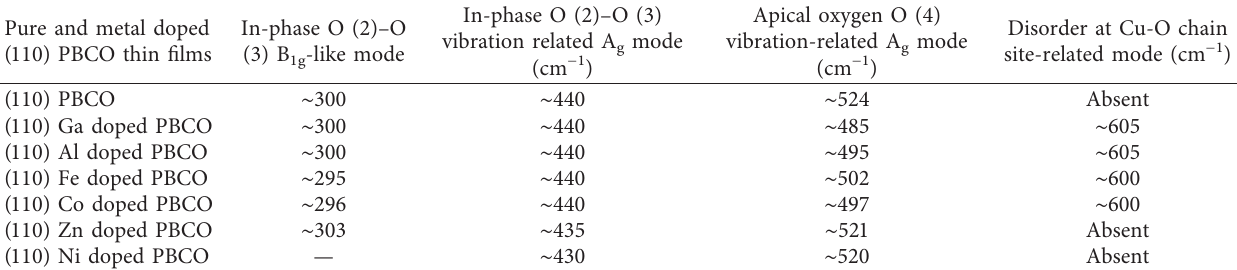
Table 2: Important Raman modes in (110)-oriented pure and Ga, Al, Fe, Co, Zn, and Ni doped PBCO thin films. Pure and metal doped In-phase O (110) PBCO thin films